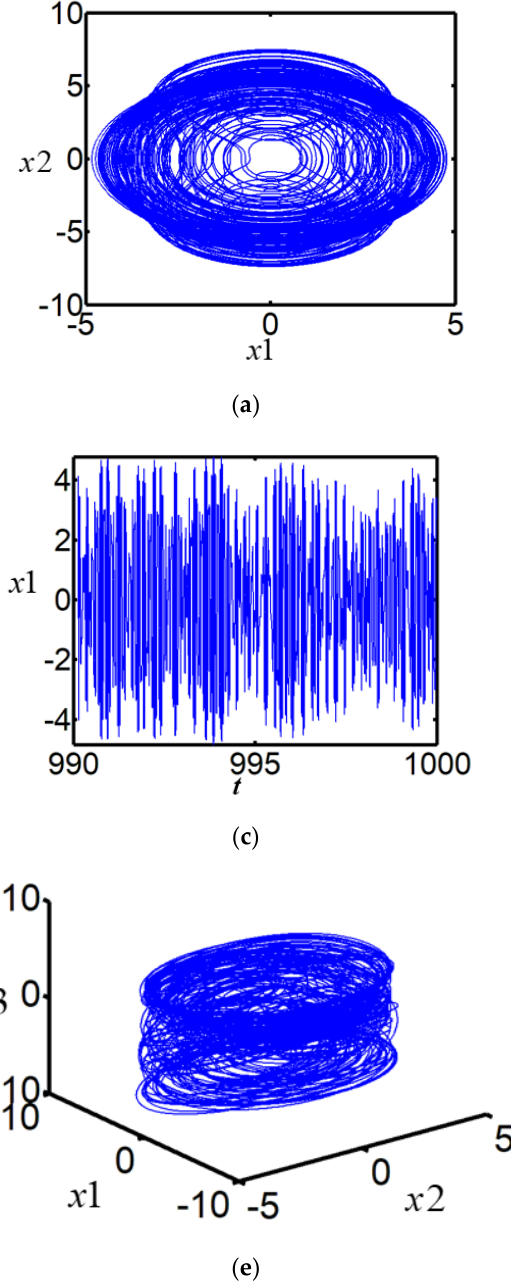
Figure 3. Nonlinear vibration in chaotic motion for the cantilever beam: ( a ) phase portrait on the plane ( x 1 , x 2 ) ; ( b ) phase portrait on the plane ( x 3 , x 4 ) ; ( c ) waveform on the plane ( t , x 1 ) ; ( d ) waveform on the plane ( t , x 3 ) ; ( e ) phase portrait in the three-dimensional space ( x 1 , x 2 , x 3 ) ; ( f ) Poincare maps on the plane ( x 1 , x 2 )